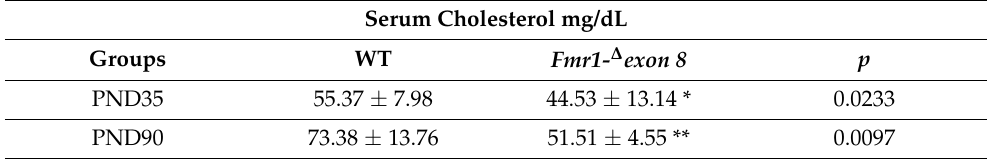
Table 1. Serum cholesterol content in adolescent (PND35) and adult (PND90) male Fmr1- ∆ exon 8 rats and their WT